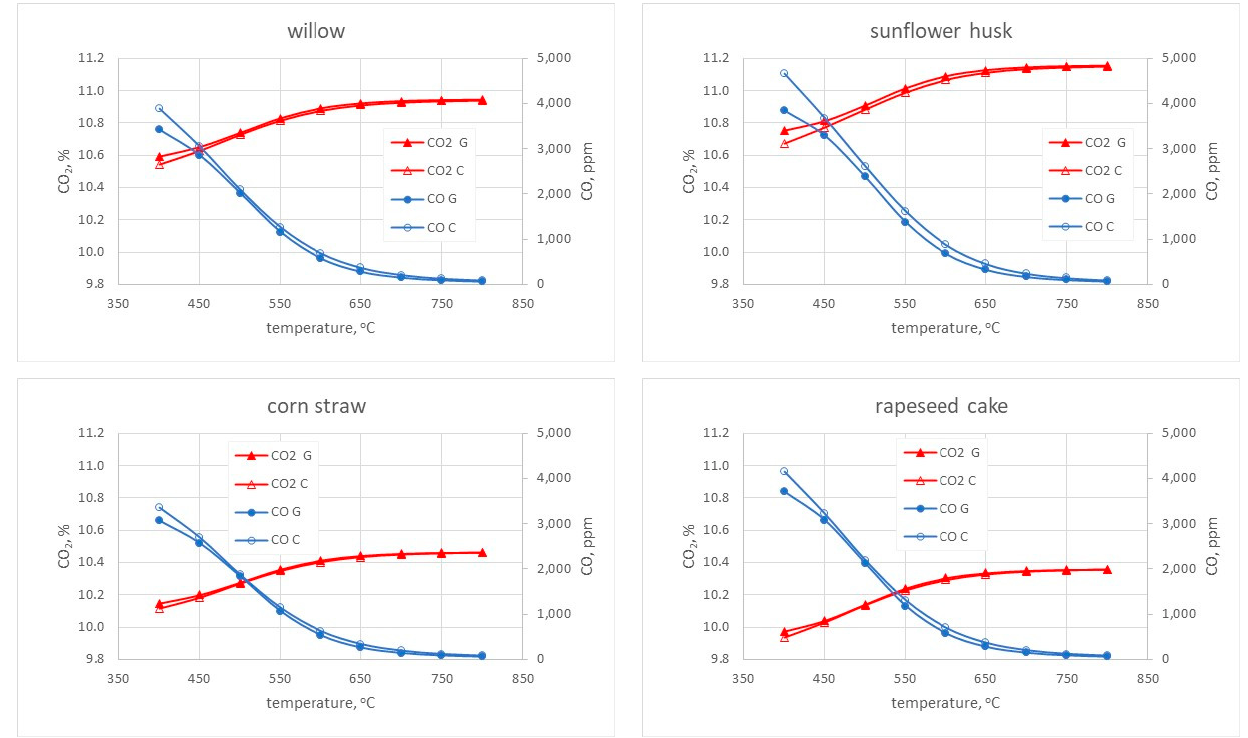
Figure 5. The dependence of CO 2 and CO shares as a function of temperature for the residence time of 60 s.